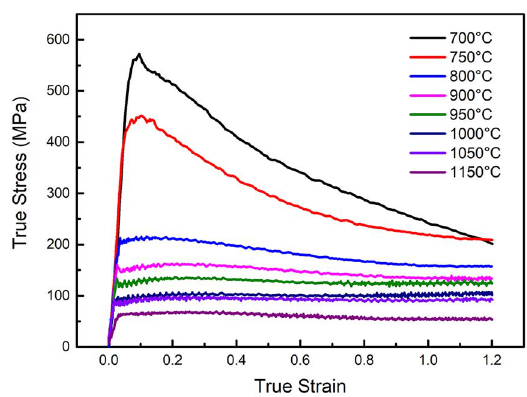
Figure 2. True stress-stain curves of as-consolidated PM Ti-5553 alloy at 1 s -1 and various